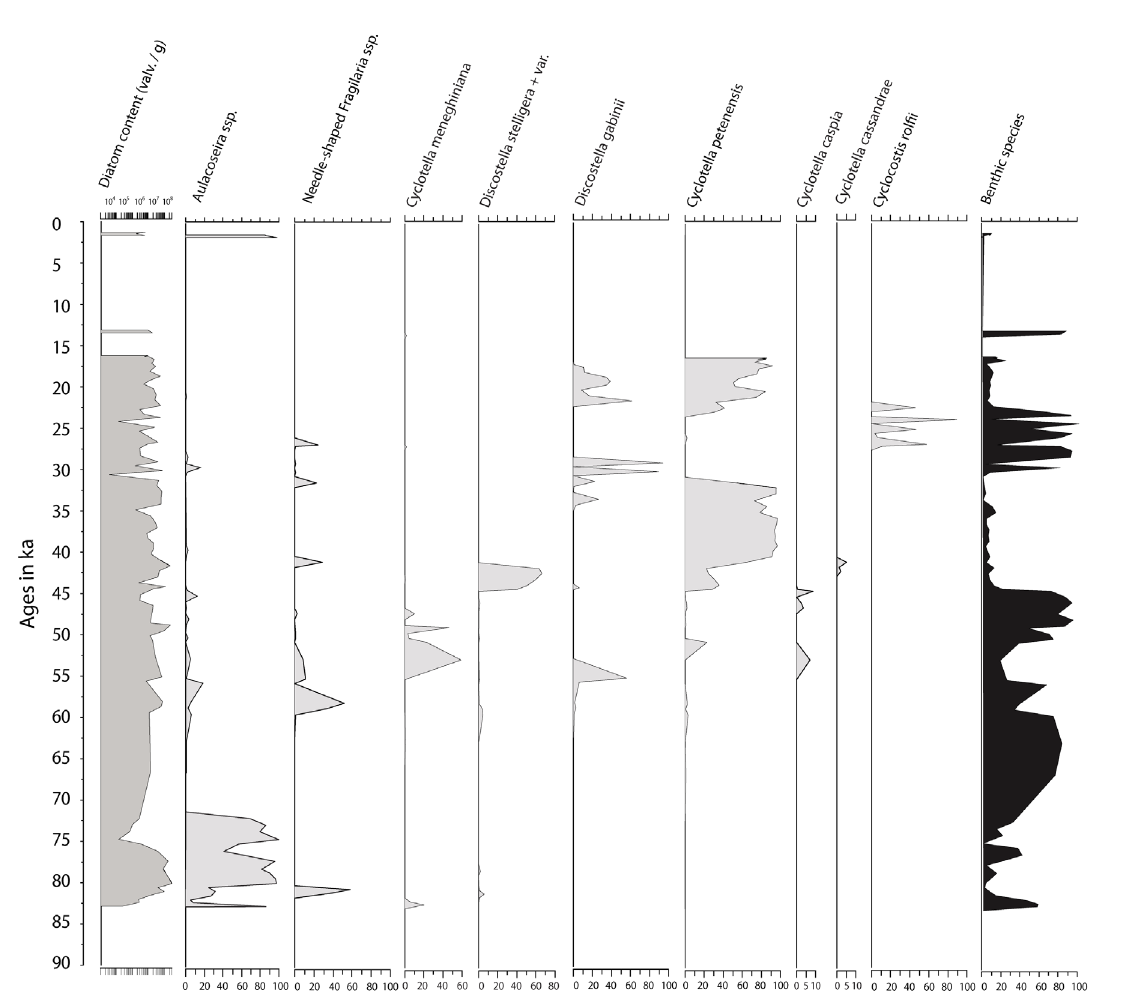
Fig. 59. Diagram showing the succession of Stephanodiscaceae Glezer & Makarova in Pleistocene sediments (0–84 ka) from Lake Petén-Itzá